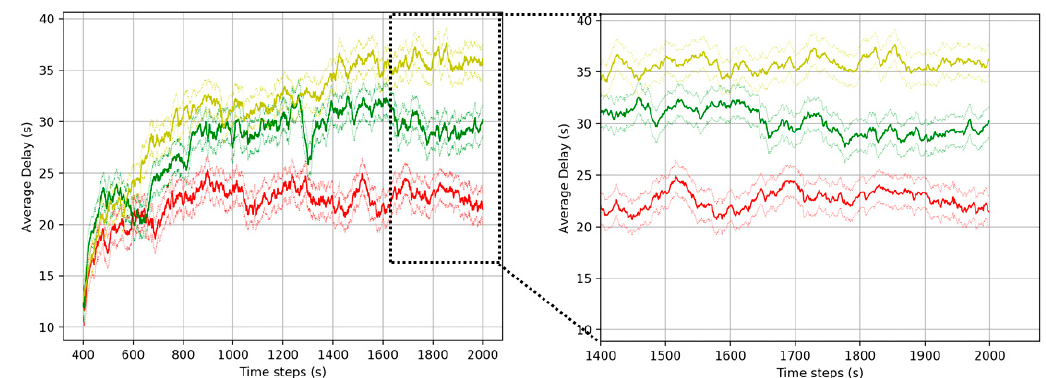
Figure 9. Performance comparison for delay.